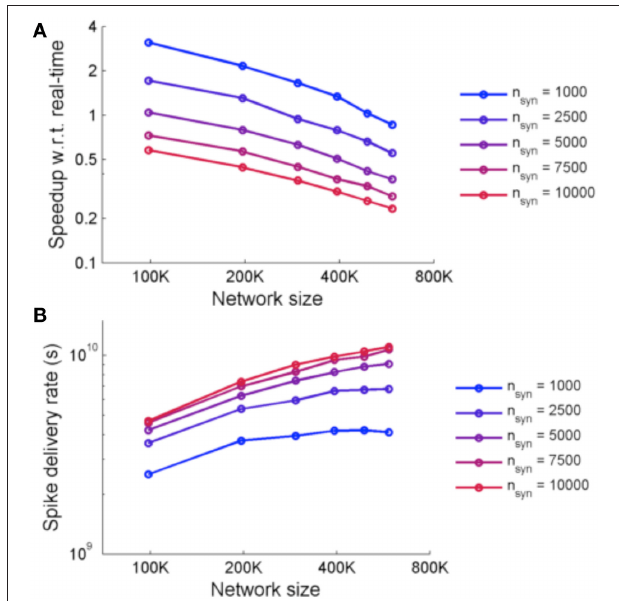
FIGURE 9 | (A) Speedup of NeuroFlow with respect to real-time and (B) performance of NeuroFlow in terms of spike delivery rate. The speedup of NeuroFlow is inversely proportional to the size of the network, and networks with smaller number of synapses per neuron run a number of times faster. Due to overhead of distributing the computations to different processors, the speedup of network is not linear to the size of the network.